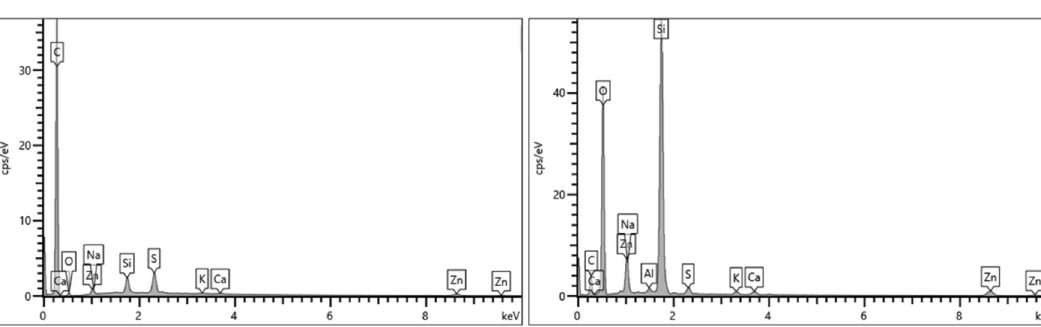
Figure 8. Elemental spectra of rubber powder before (left) and after (right)